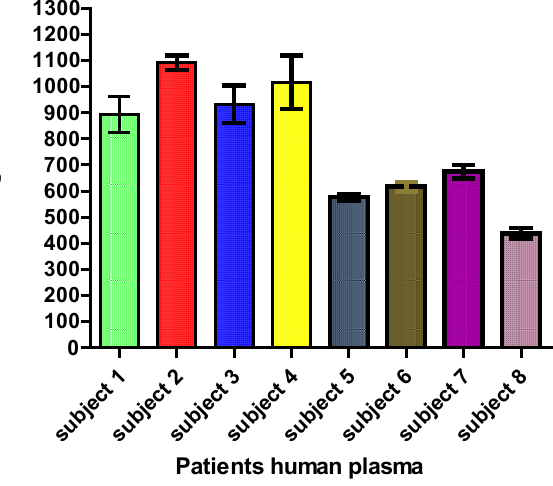
Figure 8: Results of quantification of DCV in HCV treating